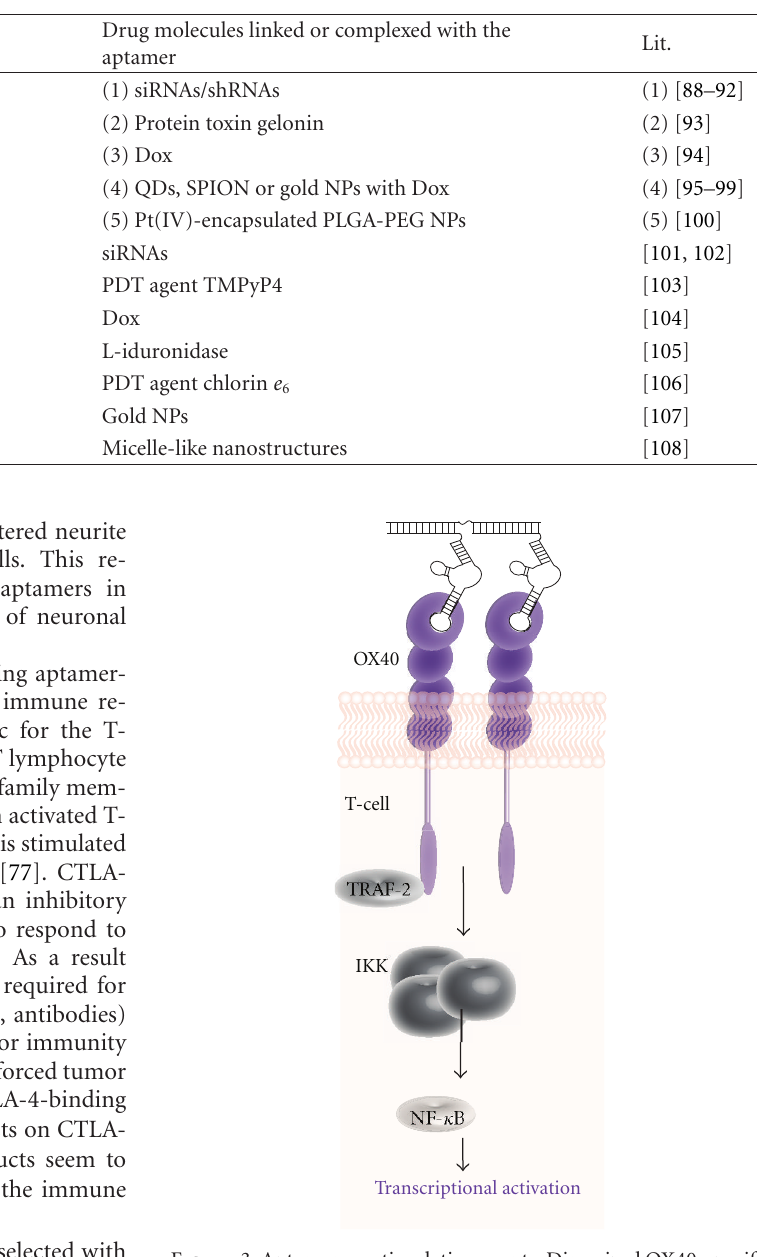
Table 3: Aptamers for cell-specific delivery of drug molecules.